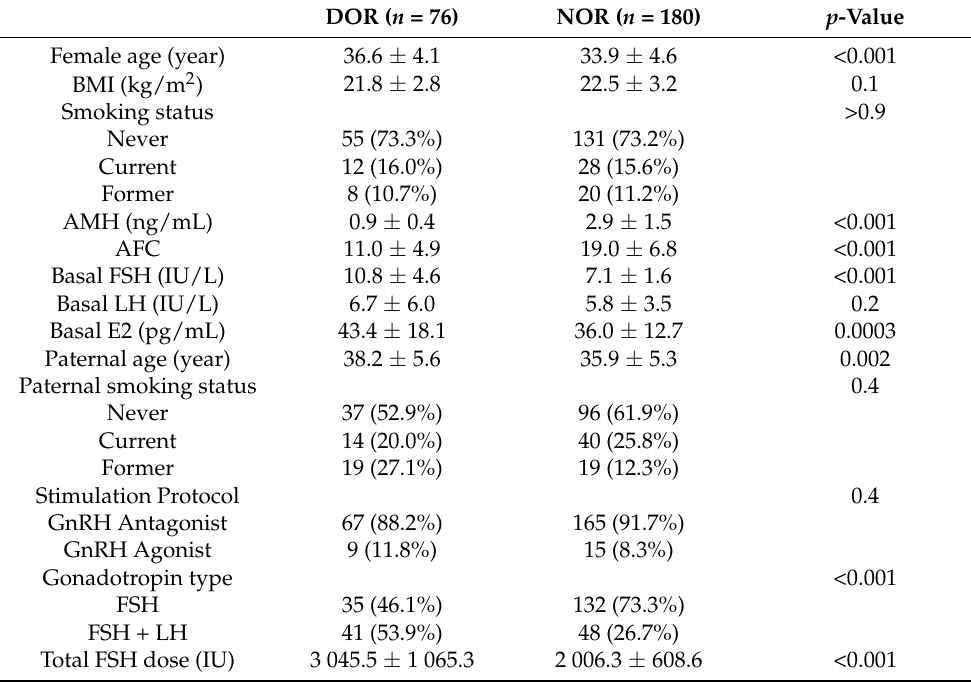
Table 1. Baseline characteristics and IVF stimulation parameters of Diminished Ovarian Reserve (DOR) versus Normal Ovarian Reserve (NOR) patients. Values are shown as mean ± SD or n (%). DOR ( n = 76) NOR ( n = 180) p -Value Female age (year) 36.6 ± 4.1 33.9 ± 4.6 <0.001 BMI (kg/m 2 ) 21.8 ± 2.8 22.5 ± 3.2 0.1 >0.9 Never 55 (73.3%) 131 (73.2%) Current 12 (16.0%) 28 (15.6%) Former 8 (10.7%)